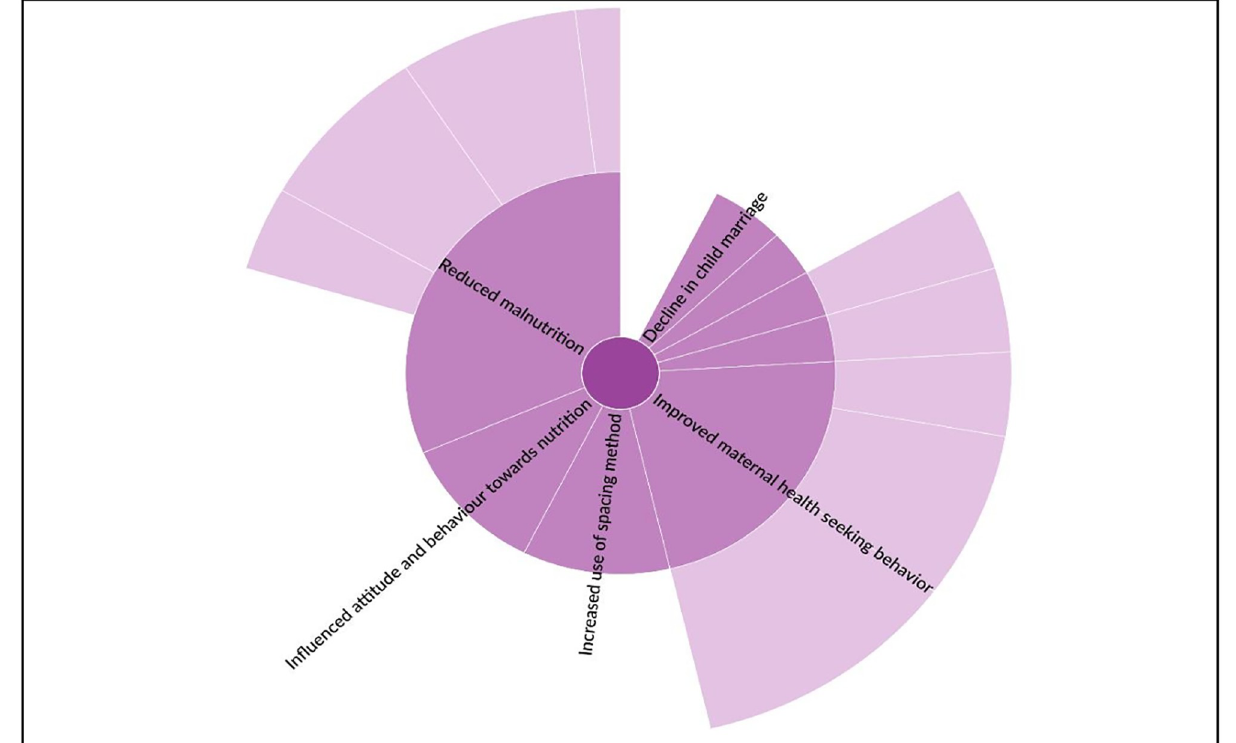
Fig 3. Poshan Sakhis as a change-maker in the community.